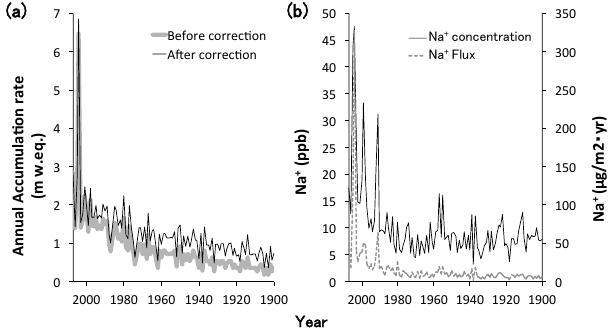
Figure 4. (a) Annual layer thicknesses of the Aurora Peak ice core (thick gray line) and annual accumulation rates corrected by the Dansgaard–Johnsen model (black line). (b) Temporal variations in average annual Na + concentrations (black line) and Na + flux (dot- ted gray